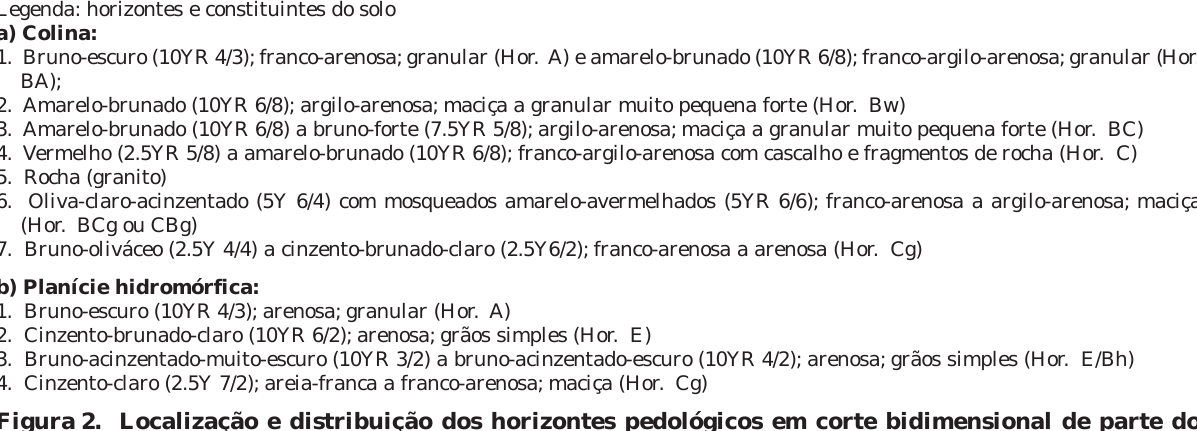
Figura 2. Localização e distribuição dos horizontes pedológicos em corte bidimensional de parte do alinhamento AB (s= tradagens ou